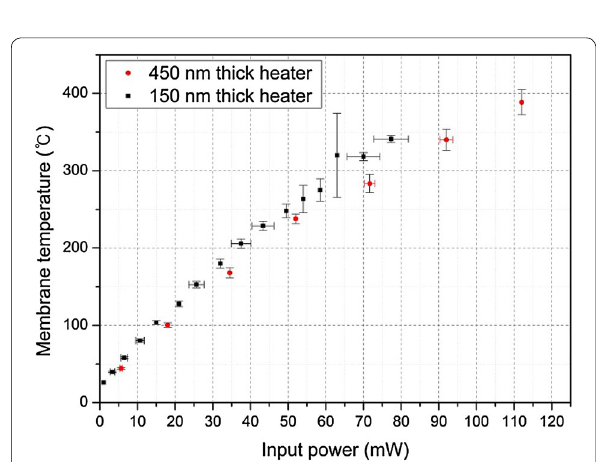
Fig. 2 Graph of input power vs. membrane temperature for one of two heaters in single chip. Two chips were fabricated with 150 nm (square) and 450 nm (circle) thick Pt films for heaters, respectively. So, he total power of two heaters in a single chip is two times the input power indicated in the